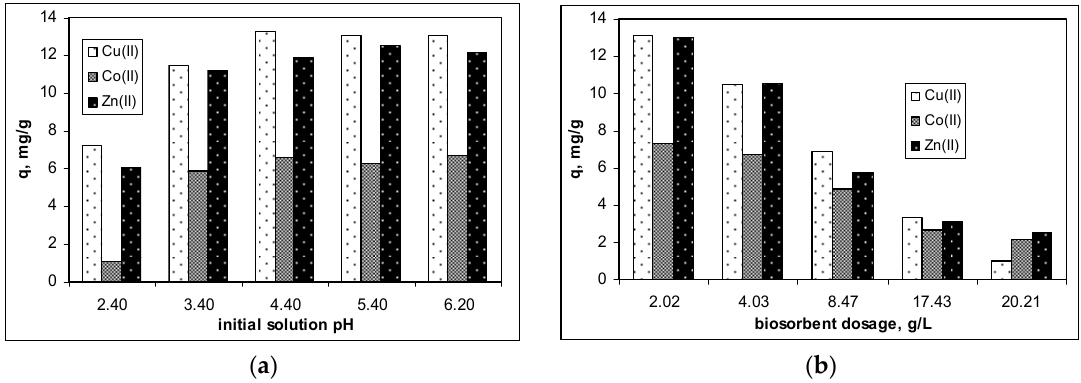
Figure 1. Influence of initial solution pH ( a ) and biosorbent dosage ( b ) on the biosorption efficiency of Cu(II), Co(II) and Zn(II) ions on alginate. (Experimental conditions: Co = 25.41 mg Cu(II)/L, 23.57 mg Co(II)/L, 27.10 mg Zn(II)/L; temperature = 22 °C).